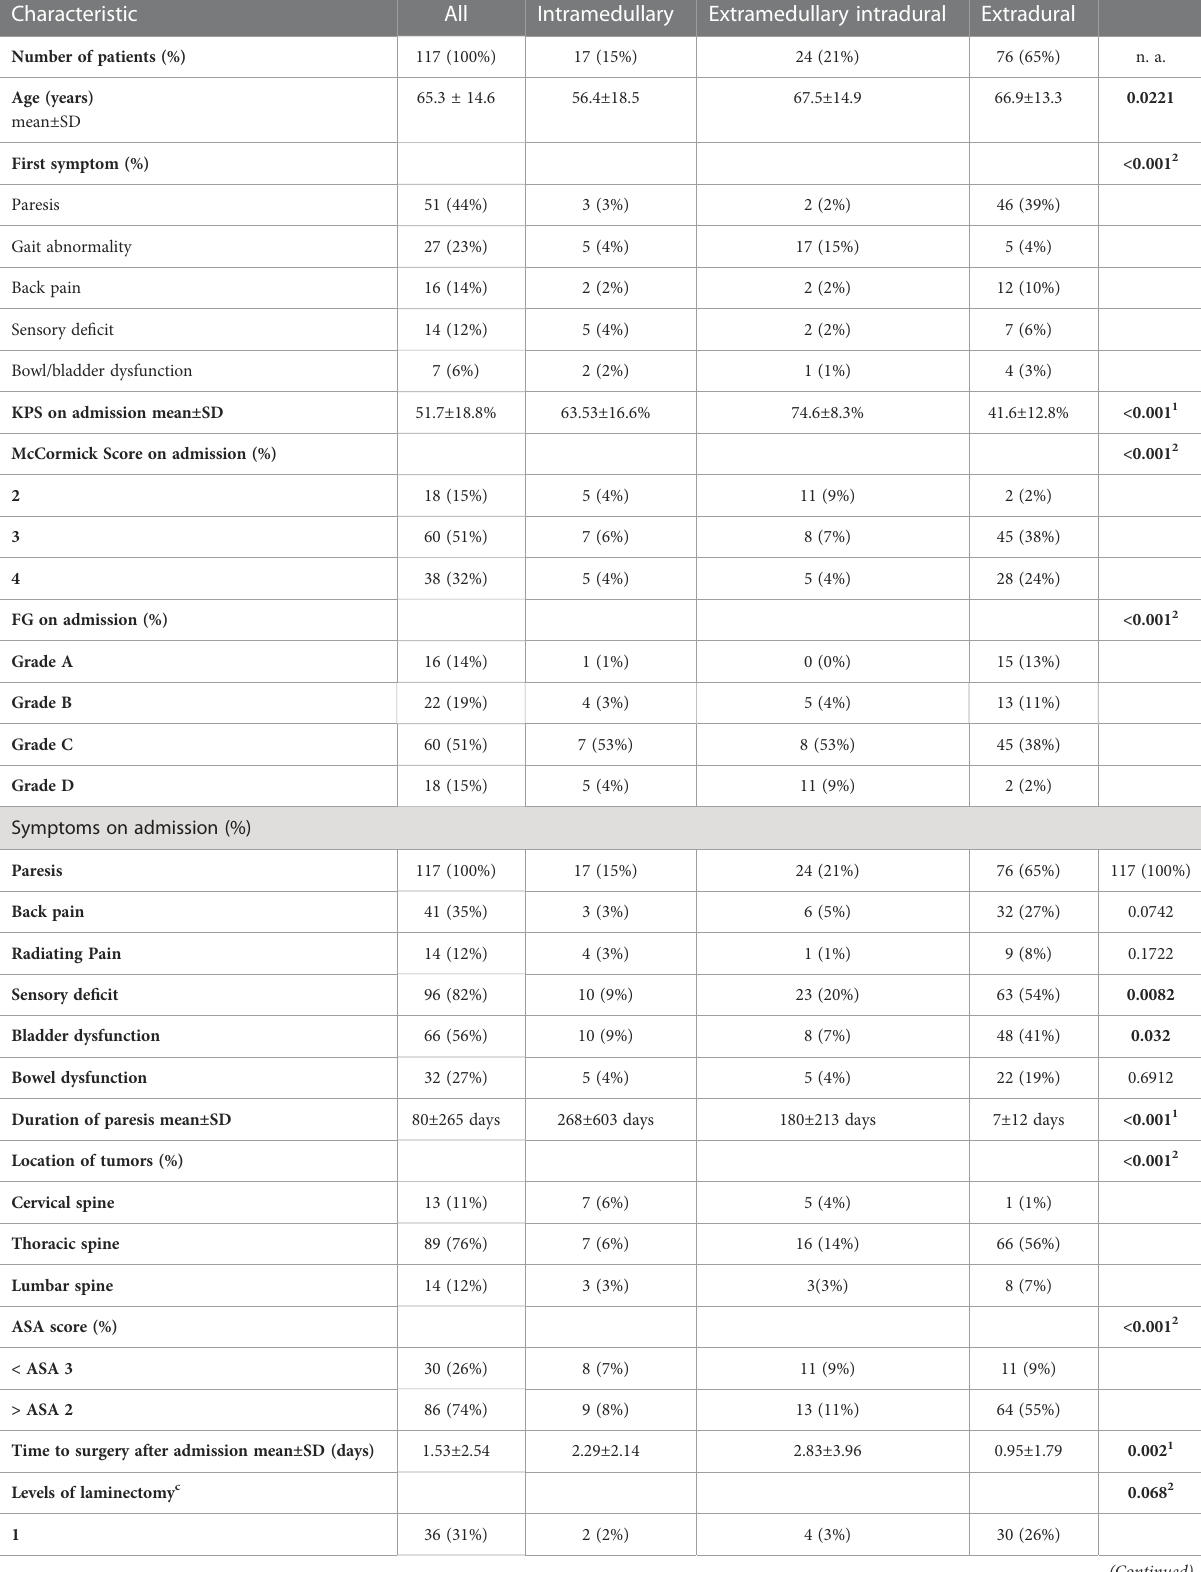
TABLE 3 Comparison of patients with different compartment localizations of